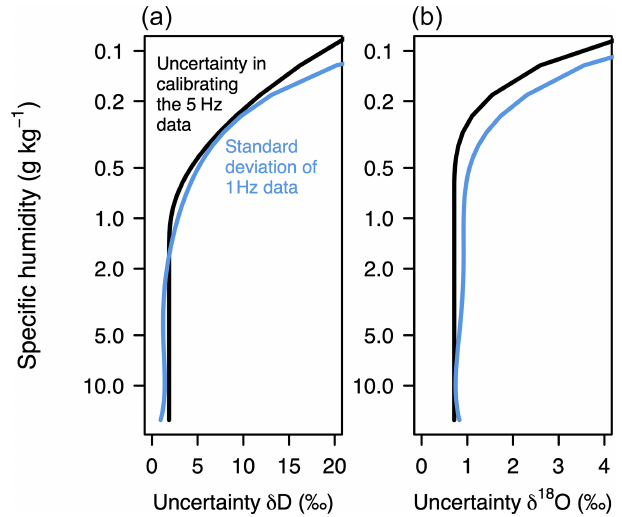
Figure 8. P-3 isotopic uncertainties ( x axis) plotted as a function of specific humidity ( y axis). The y axis is plotted on a logarithmic scale to convey the tendency toward higher uncertainty with aircraft altitude. Black lines represent the uncertainties associated with cal- ibrating the 5Hz data. Blue lines represent the standard deviations associated with the 1s averages from the first two research flights: they reflect both the variability of the environment and the impreci- sion of the isotopic analyzer in flight.